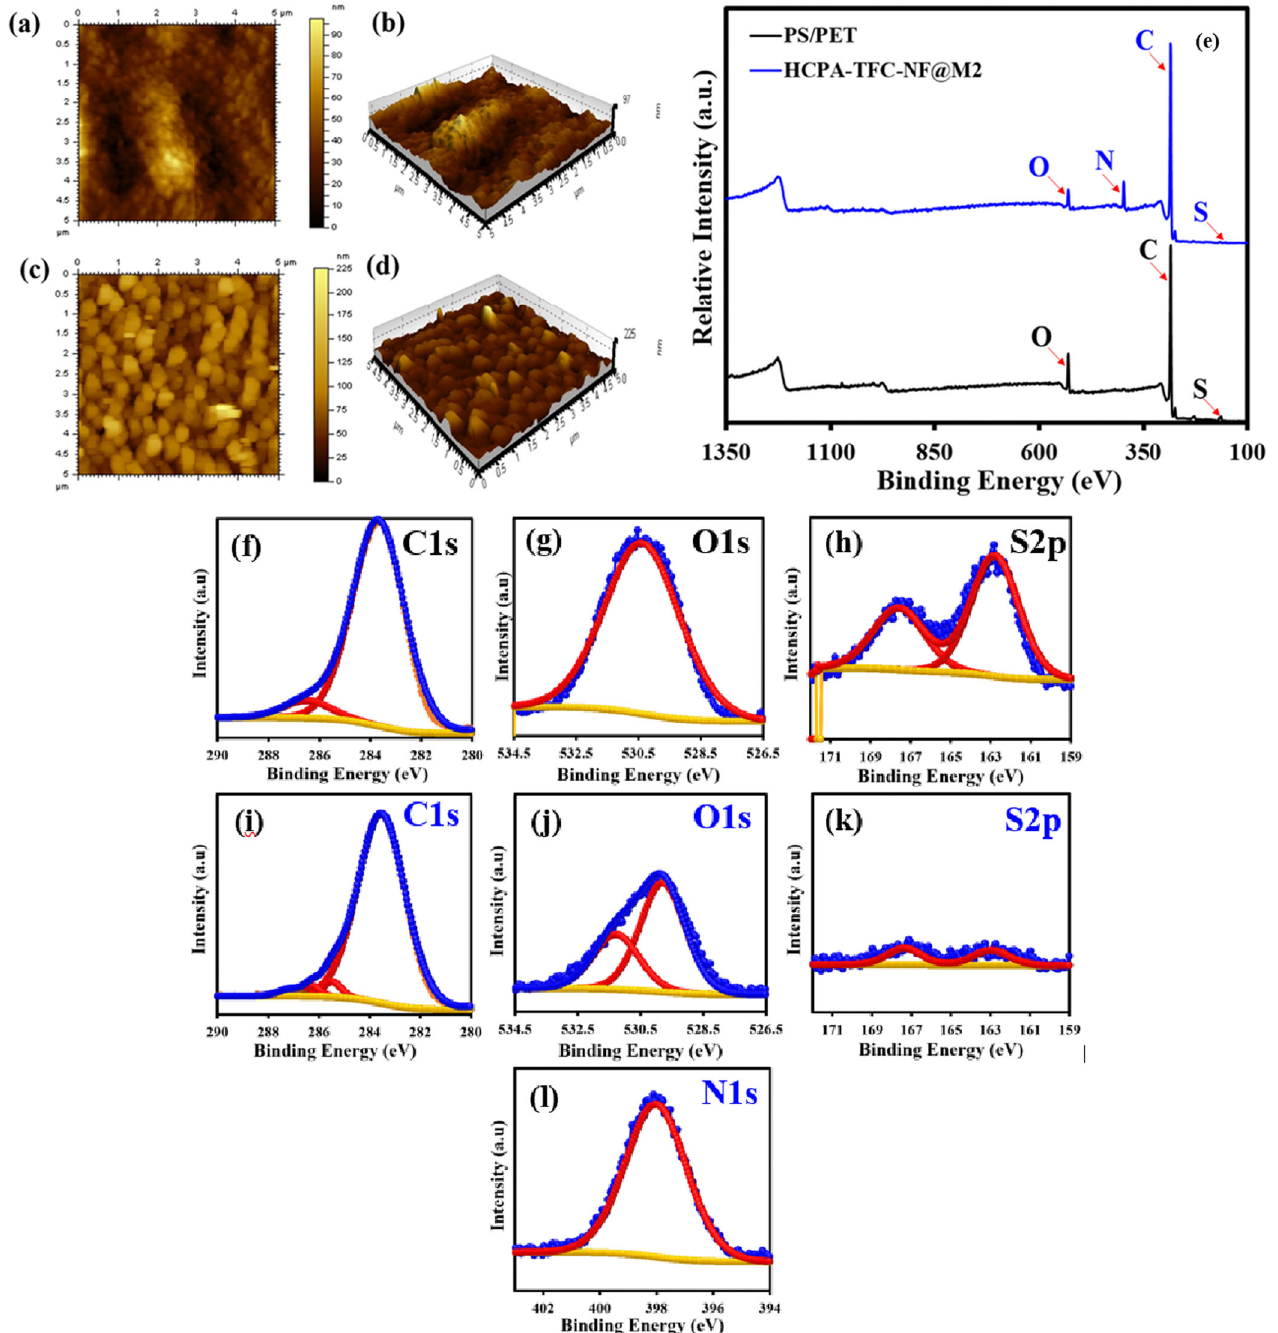
support and i – l HCPA-TFC-NF@M2